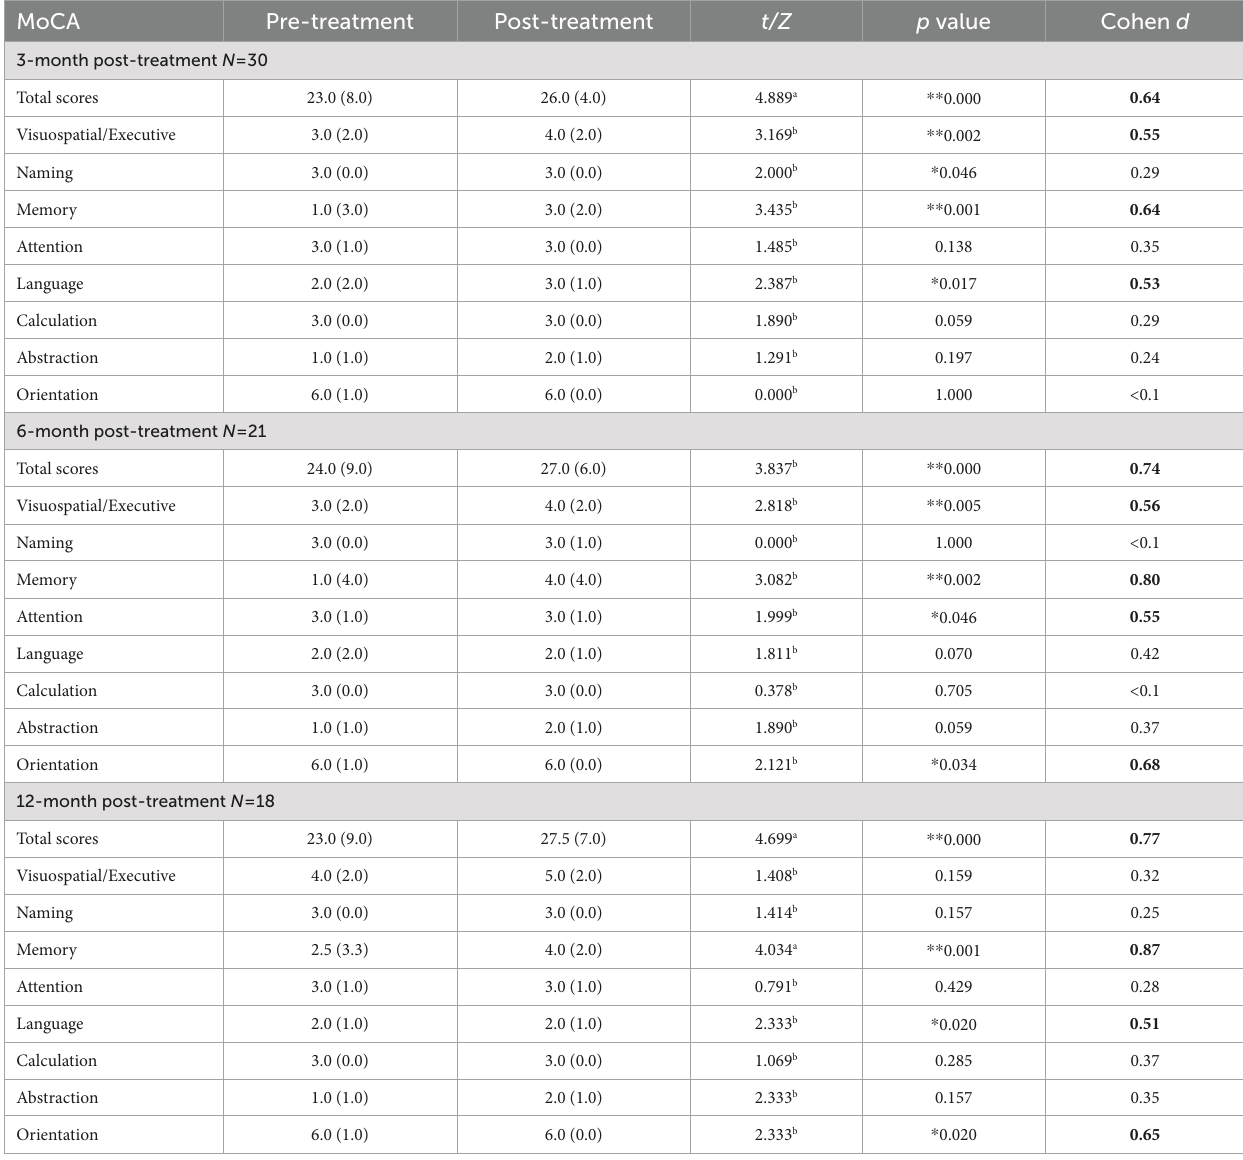
TABLE 5 Comparison of MoCA pre- and post-treatment for MD patients. MoCA Pre-treatment Post-treatment t/Z p value Cohen